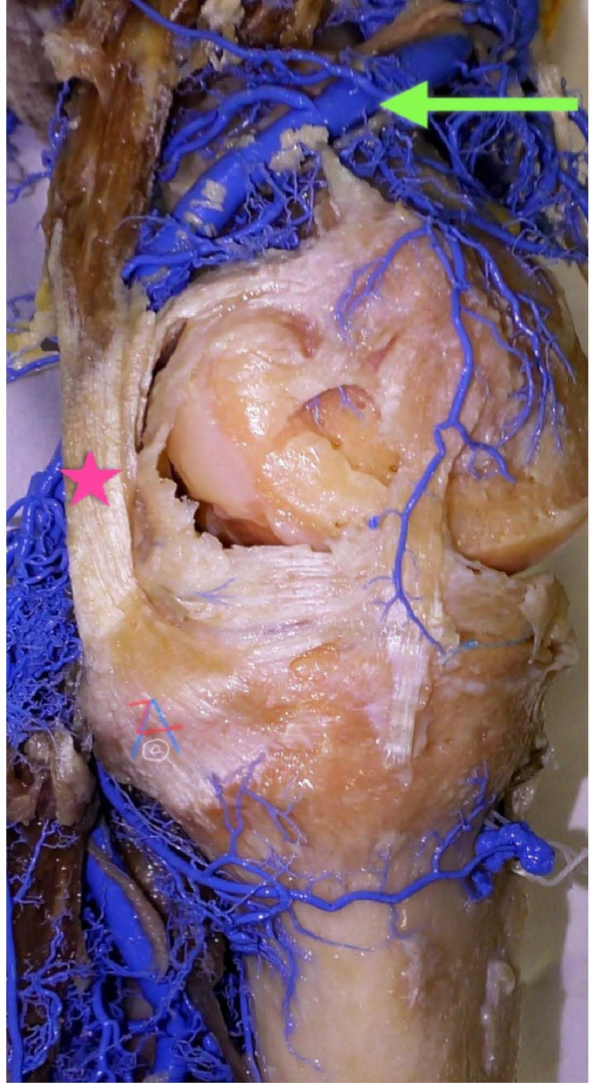
Figure 1. Left knee, medial side. The transition of the femoral artery (green arrow) through the distal part of the Hunter’s canal to become the popliteal artery posteriorly. Pink star: the remains of hamstrings after chemical debridement before forming pes